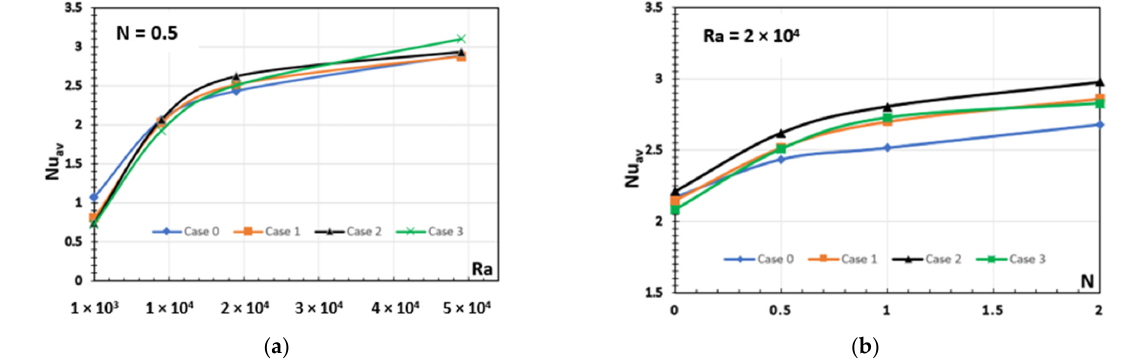
Figure 7. Effect of Rayleigh number ( a ) and buoyancy ratio for Ra = 2 × 10 4 ( b ) on the average heat transfer rate in all cases for θ = 0°.